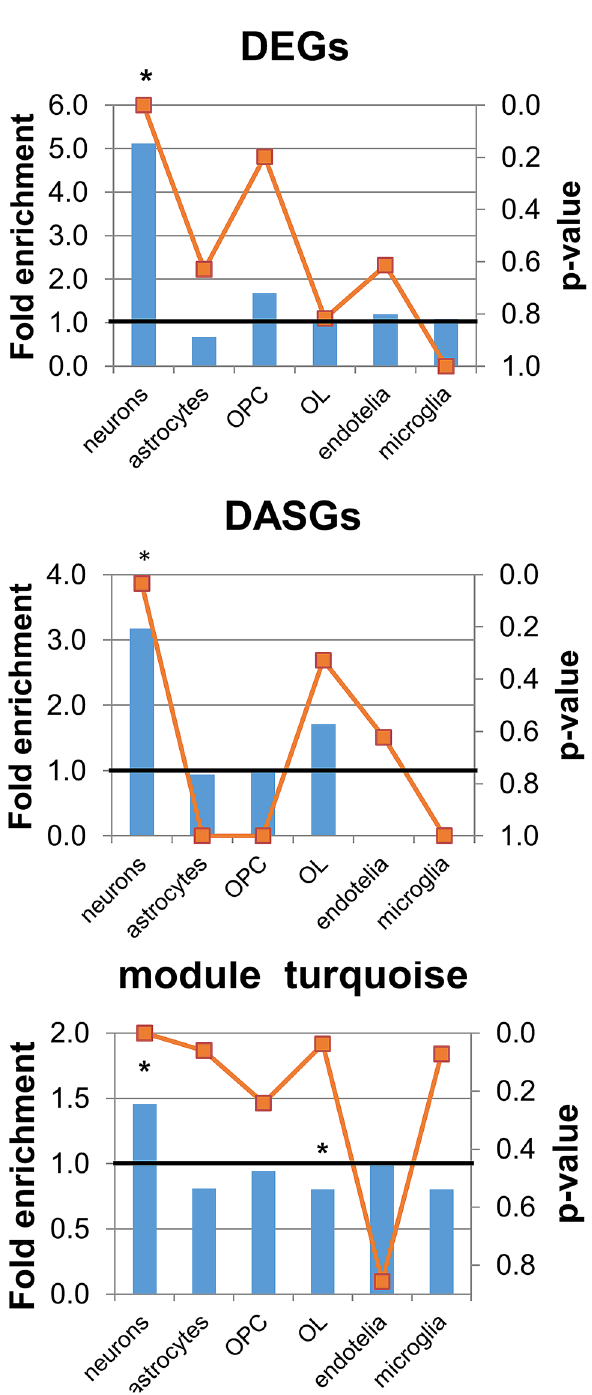
Figure 5. Cell type enrichment analysis. The left Y-axis and histogram illustrate fold enrichment by cell type, whereas the right Y-axis and the orange line denote significance of the changes. *p < 0.05 as compared with a chance occurrence. OPC oligodendrocyte precursor cells, OL mature oligodendrocytes. The sets of DEGs and DASGs and the turquoise module are more enriched with neuron-specific genes than expected by